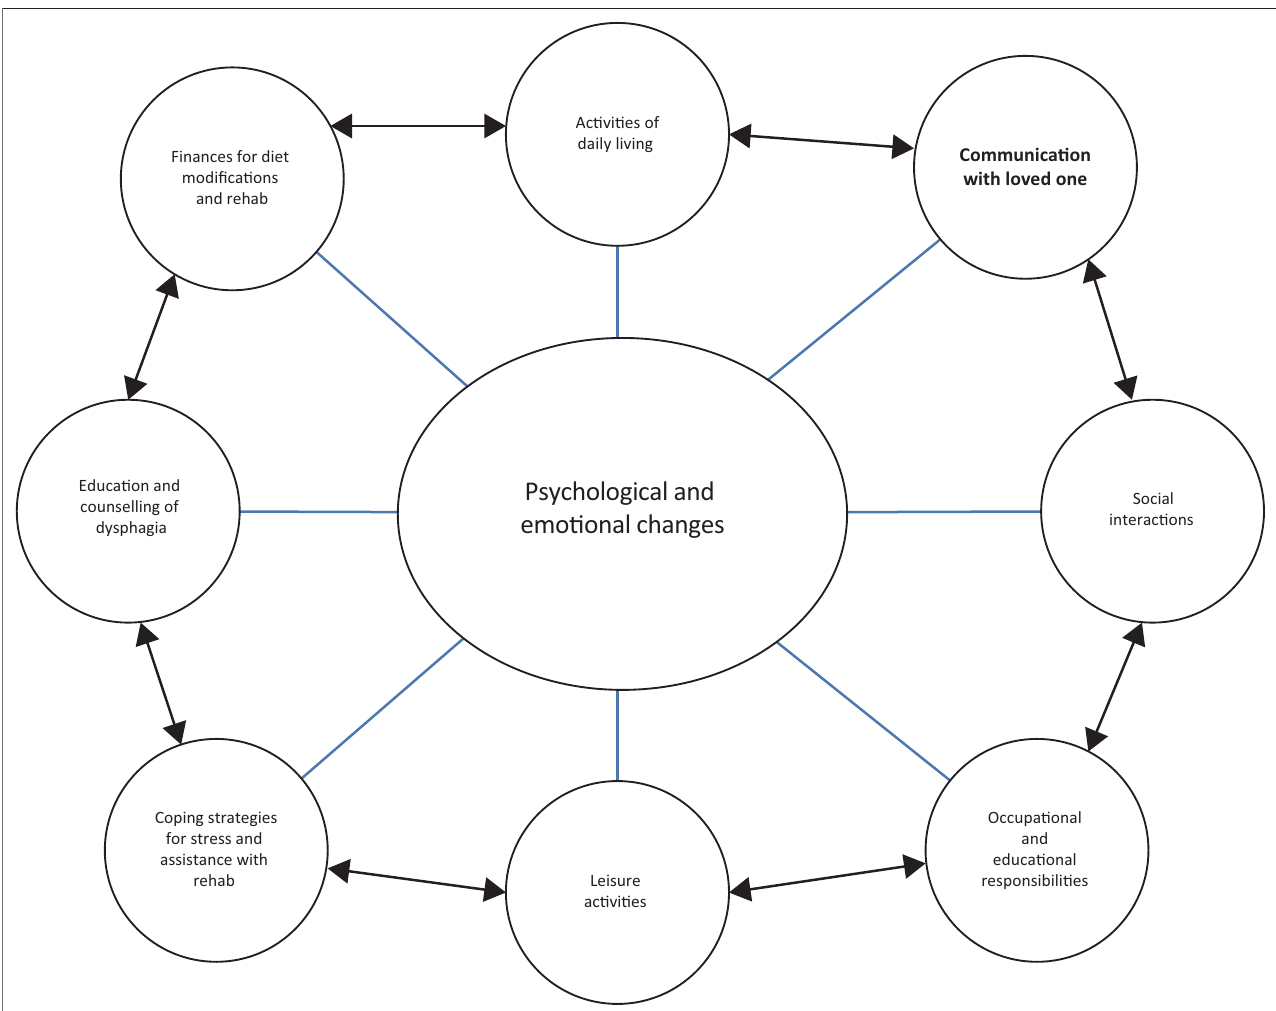
FIGURE 4: Suggested visual representation for understanding the impact of third-party disability of family members for adults with dysphagia in an economically developing